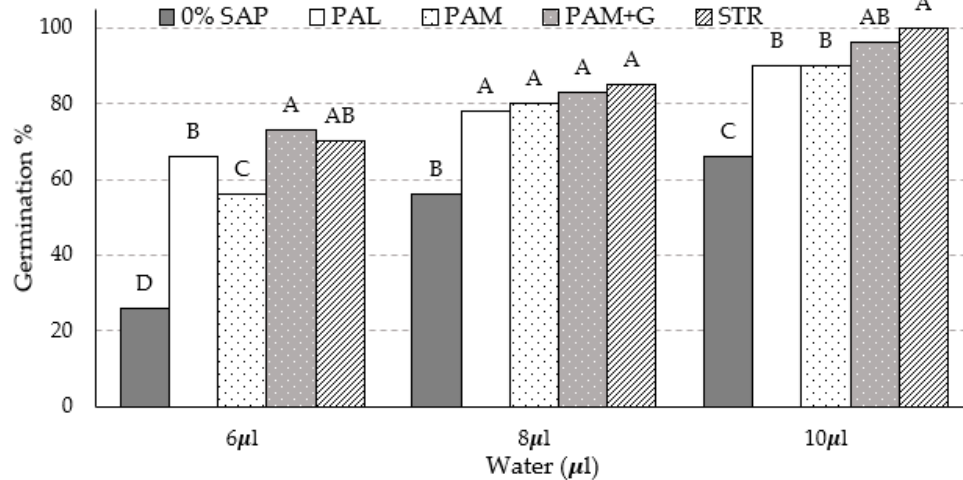
Figure 6. Germination % after 48 h with controlled hydration (6, 8, and 10 µL water added per seed) at 10/20 °C. Different letters indicate significant differences for each available water level ( p < 0.05). To simulate drought stress during germination, all six treatments were sown under controlled conditions in Montmorillonite clay media. The media was air-dried after sowing, and the containers were sealed after 40 h (MC 45%). One week after broadcasting in Montmorillonite clay media, total germination was 67% for the non-treated controls and 60% for the 0% SAP group. To compare, germination was 93–98% for the red clover seeds coated with all 2% SAP treatments (Figure 7). The Timson’s indices [26] for germination velocity in the non-treated control, 0% SAP, PAL, PAM, PAM+G, and STR groups were 169, 118, 282, 288, 283, and 284, respectively (where greater values have higher and faster germination rates). Collectively, all 2% SAP formulations had similar Timson’s index values, ranging from 282 to 288, compared to the non-SAP checks.